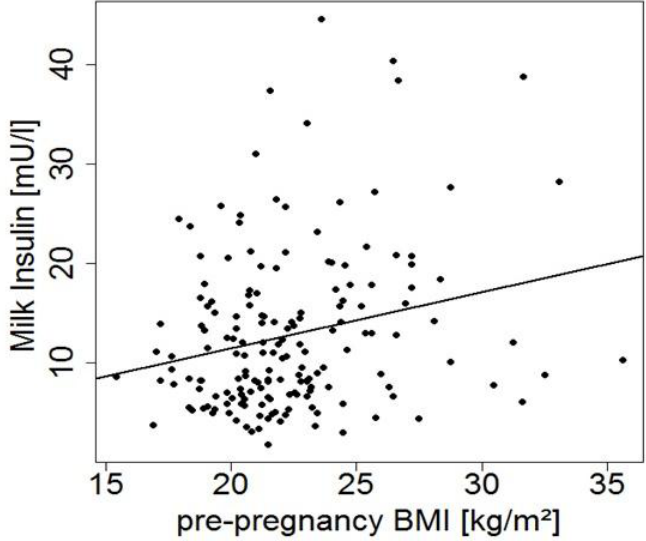
Figure 1. Milk insulin levels in early milk samples versus maternal pre-pregnancy body mass index (BMI) ( r = 0.24, p = 0.002, n = 175).